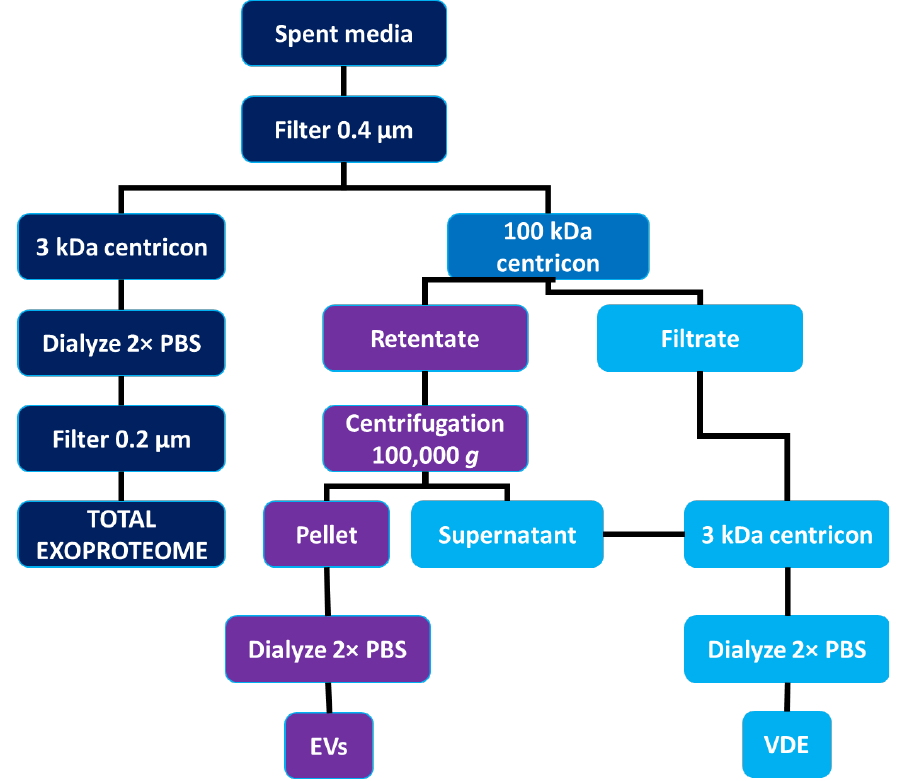
Figure 2. Recovery approach used to compare different exoproteome fractions as proposed in [76]. PBS, phosphate-buffered saline.